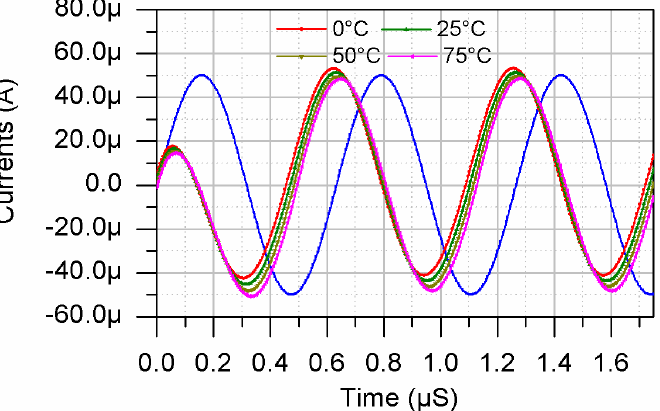
Figure 8. Transient responses of differential AP output currents at 0, 25, 50 and 75 °C.